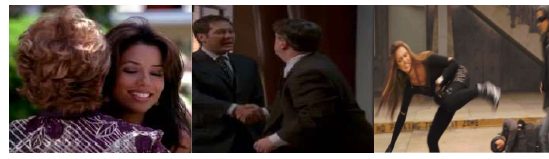
Figure 26. Samples from HOLLYWOOD 2 dataset [216].